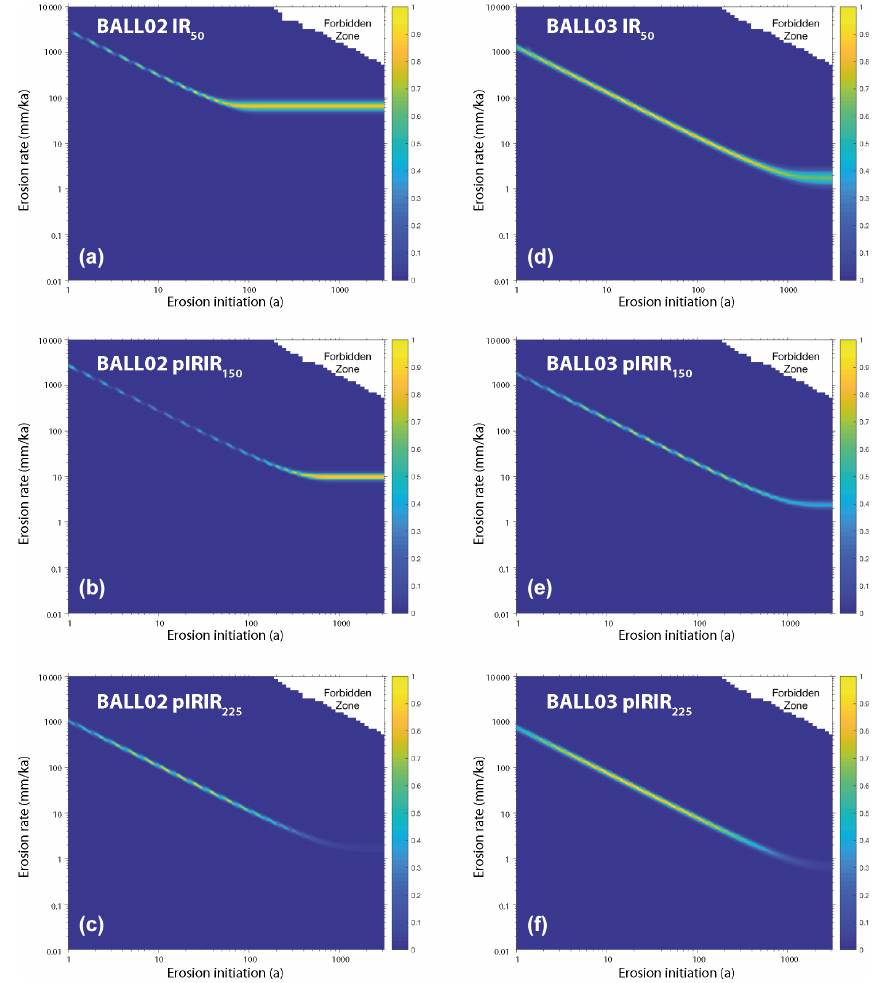
Figure 7. Probability distributions inverted from the respective plots of luminescence depth profiles derived from the inversion results (using the approach of Lehmann et al., 2019a) for samples BALL02 (a–c) and BALL03 (d–f) using the IR 50 (a, d) , pIRIR 150 (b, e) and pIRIR 225 (c, f) signals. The x axis plots the time interval of the erosion rate initiation. Forbidden zones define the range of solutions with high erosion rates and durations that are not feasible within the bounds of the experimental 10 Be and luminescence data.